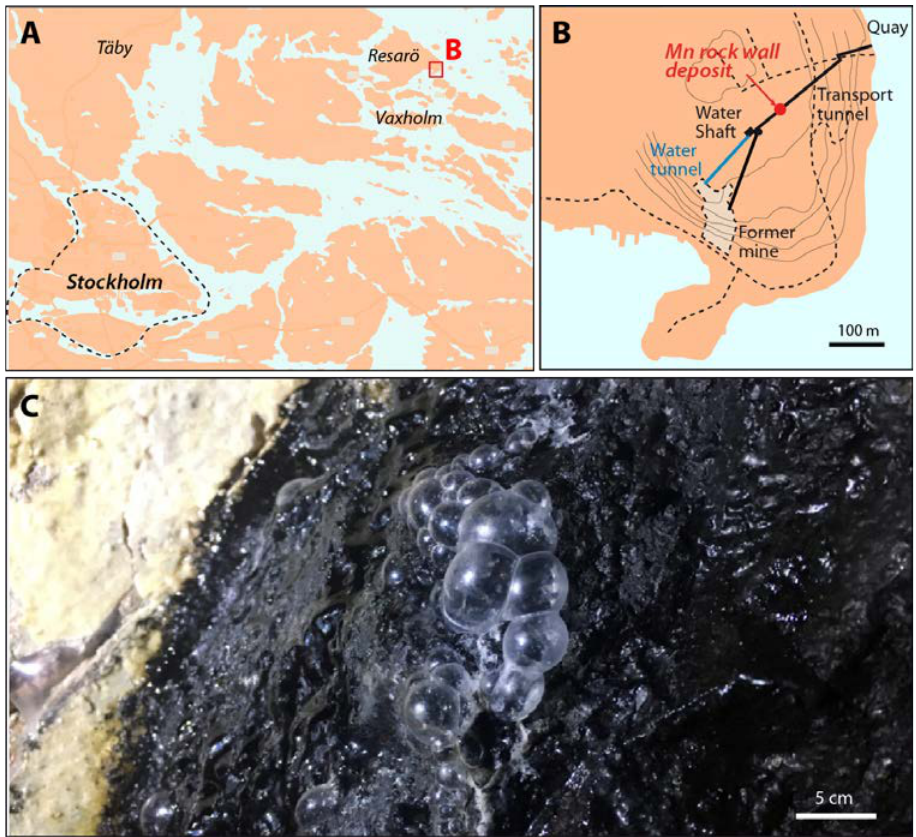
Figure 1. Maps showing the location of the Ytterby mine and the Mn deposit. ( A ) Map of the Stockholm area with position of Resarö and the Ytterby mine indicated. ( B ) Map of tunnel connecting the Ytterby mine shaft with a more recently constructed quay to the NE. ( C ) The Mn oxides precipitate from water provided by rock fractures that crop out in the tunnel. Modified from Swedish Fortifications Agency [16].